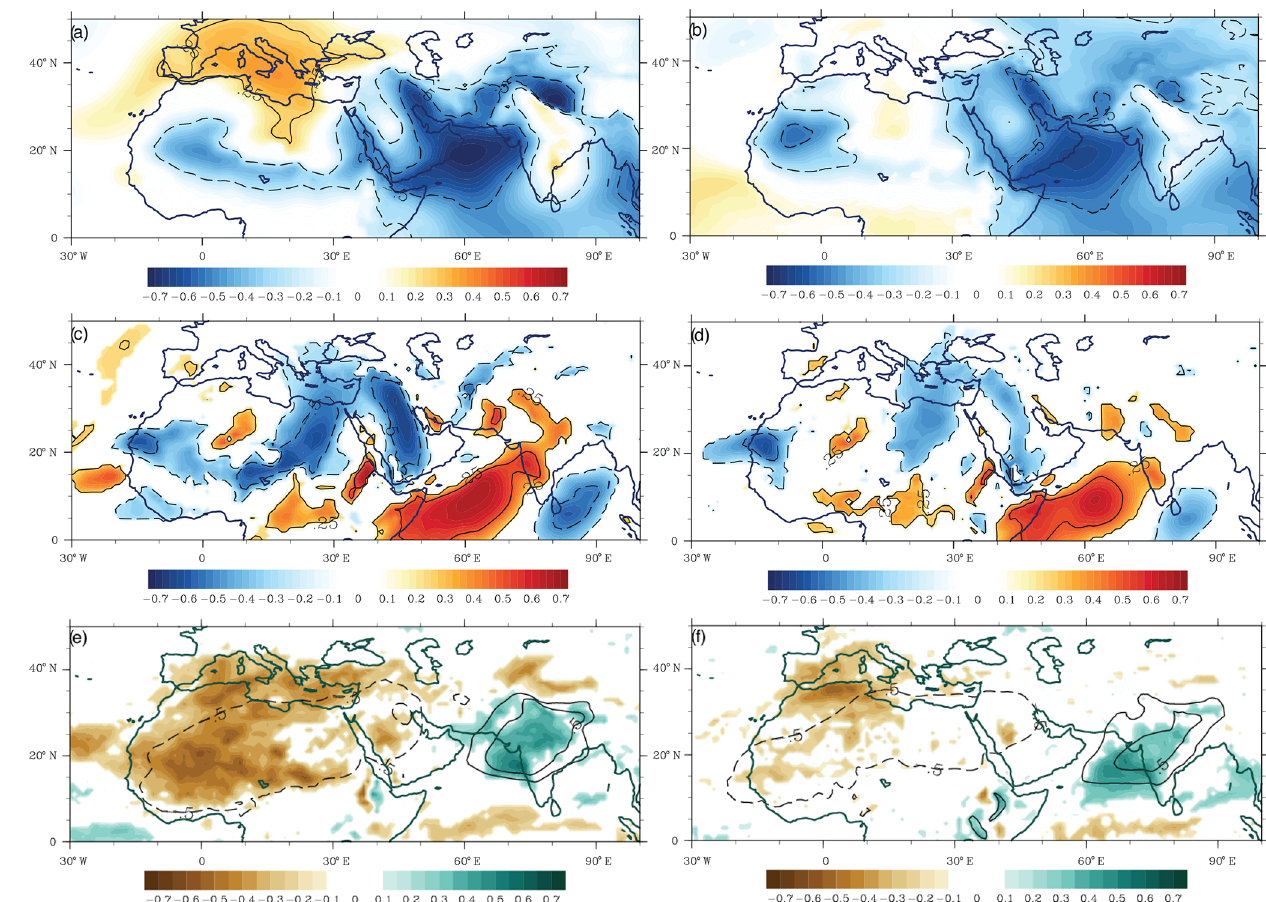
Figure 9. Correlations between the PC1 time series of ω at 500hPa in July and surface atmospheric circulation in the periods (a, c, e) 1960– 2010 and (b, d, f) 2050–2100. Correlation values are estimated for (a, b) SLP (shaded and contours), (c, d) meridional wind (shaded and contours), (e, f) precipitation (shaded), and vertically integrated water vapor (contours for the values − 0 . 5, 0.3, 0.5). For (a) – (d) contours are shown for 0.25 and 0.5 correlation